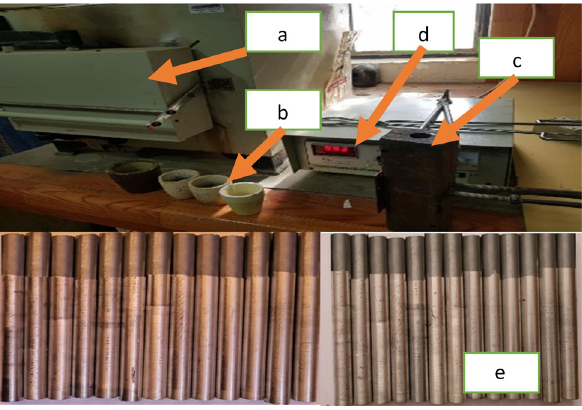
Figure 5: ( a ) Furnace; ( b ) melting pots; ( c ) molds; and ( d ) samples of FGMs ( e ) Controller of temperature.